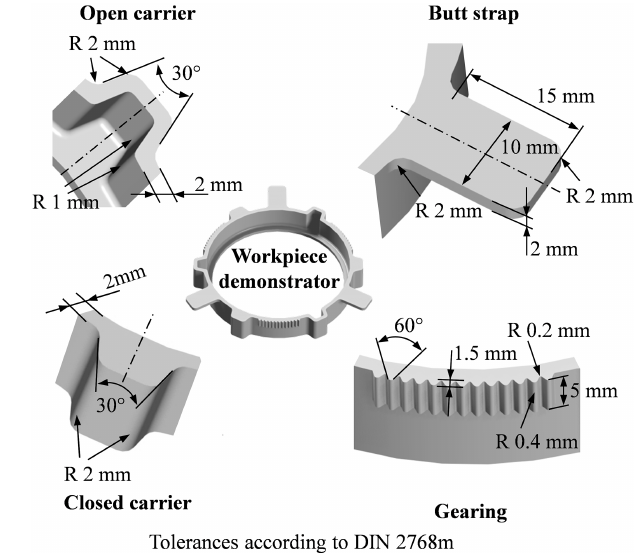
Figure 5. Workpiece demonstrator of sheet-bulk metal-forming processes with its differing sizes and shapes.